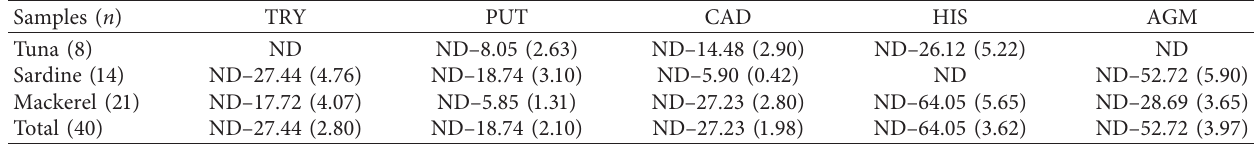
Table 5: Range and mean of five biogenic amines (mg kg − 1 ) in canned fish products in Ghana. Samples ( n ) TRY PUT